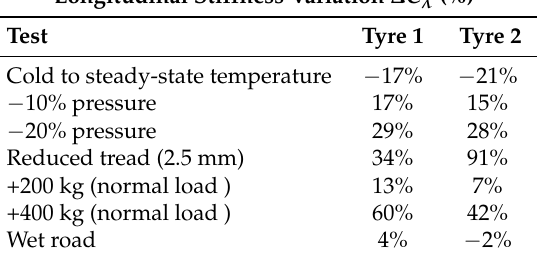
Table 4. Longitudinal stiffness changes for different tyre temperature, inflation pressure, tread depth, normal load, and road surface wetness